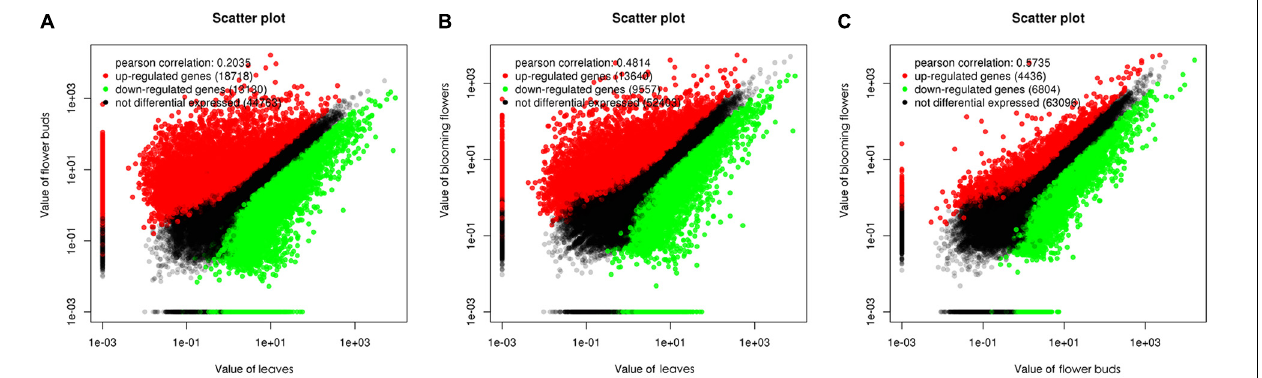
FIGURE 5 | Scatter plots of differentially expressed genes among three Chrysanthemum dichrum plant tissues. The values in the vertical and vertical coordinates are gene expression levels. (A) The x-coordinate is the gene expression level of leaves, and the y-coordinate is the gene expression level of flower buds. (B) The x-coordinate is the expression level of leaves, and the y-coordinate is the expression level of blooming flowers. (C) The abscissa is the gene expression level of flower buds, and the ordinate is the gene expression level of blooming